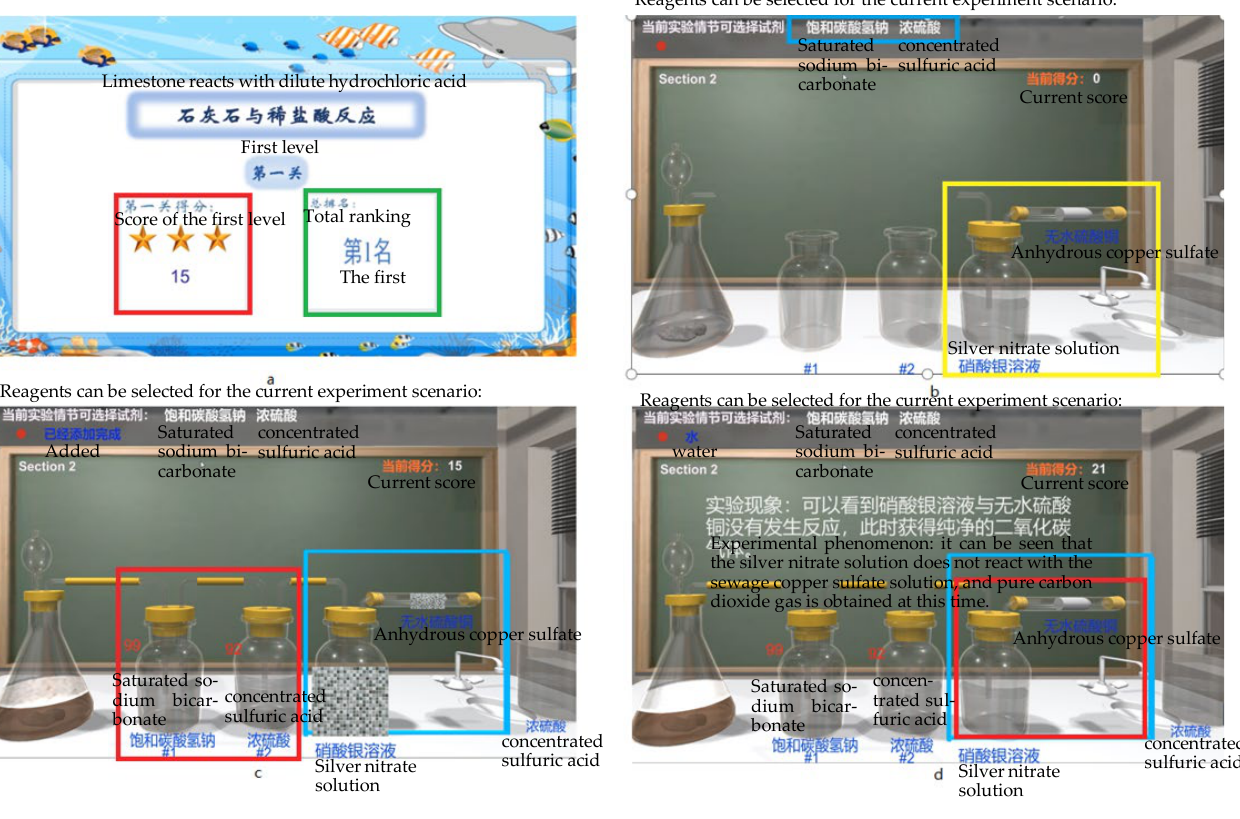
Figure 9. Limestone and dilute hydrochloric acid experiment scene 4. ( a ). Beaker operation inter- face. ( b ). The second test phenomenon interface. Let us explore the influence of the amount of limestone and dilute hydrochloric acid on the chemical reaction during the reaction of limestone and dilute hydrochloric acid. We use the controlled variable method to present different experimental phenomena. First, we do not change the amount of limestone or the concentration of dilute